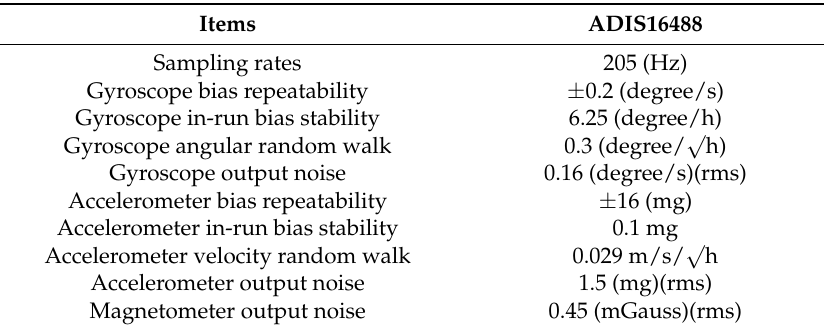
Figure 10. ADIS16488 micro-electro-mechanical-system inertial measurement unit (MEMS-IMU) system.